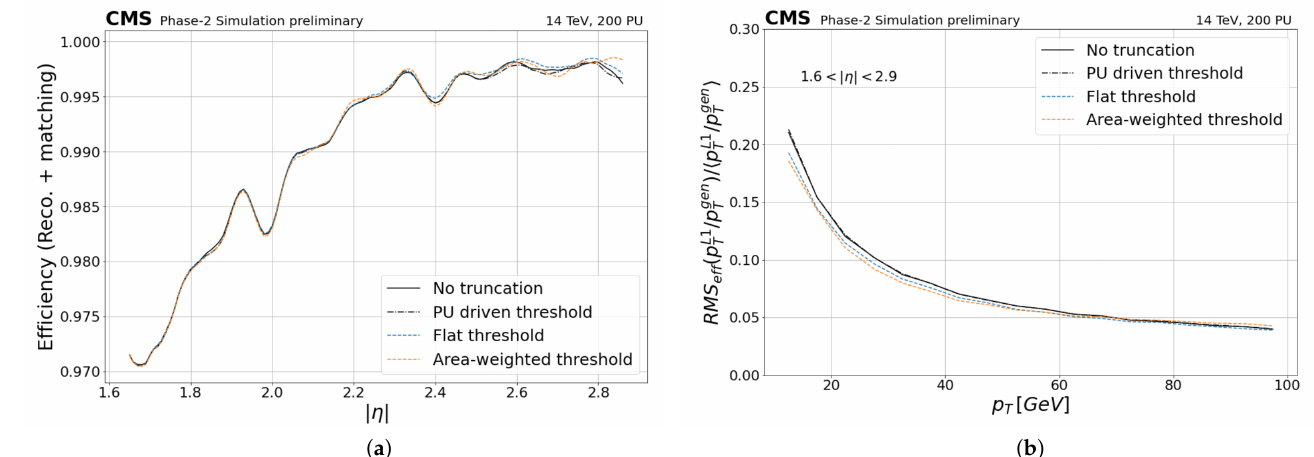
Figure 5. Impact of the truncation threshold definition on e / γ clustering performance. ( a ) Reconstruc- tion efficiency as a function of | η | . The | η | range is reduced with respect to the HGCAL acceptance to remove possible border effects. ( b ) Momentum resolution as a function of the reconstructed cluster’s p T .